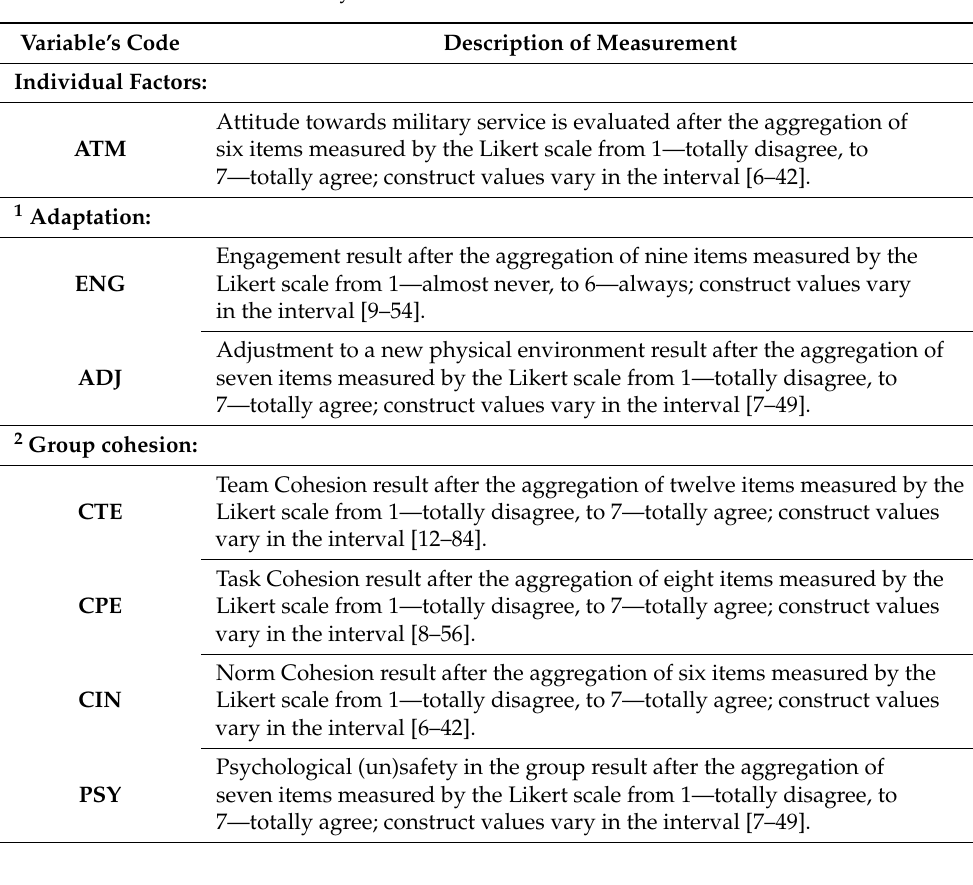
Table 1. Variables used in the